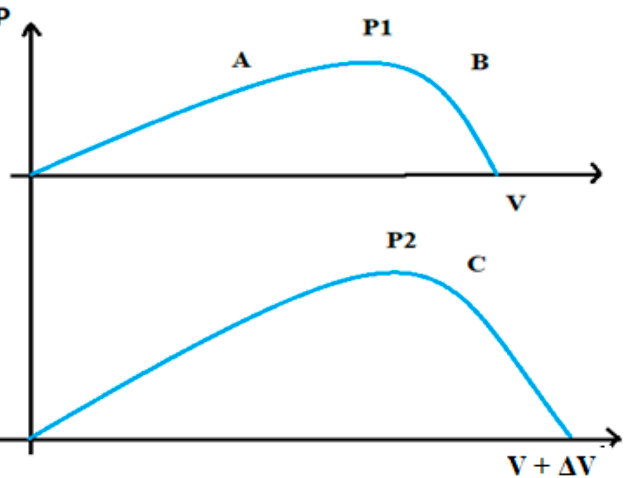
Figure 5. Performance of the P&O method in the face of climate change.